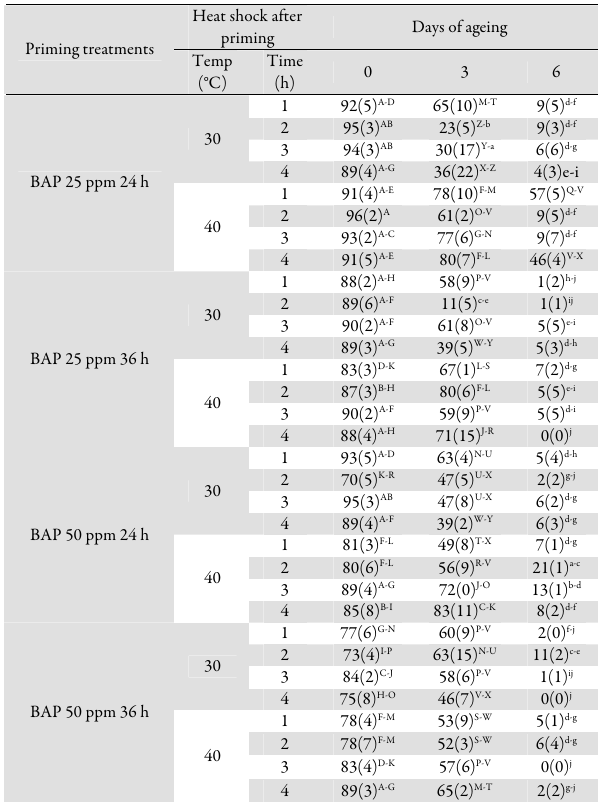
Tab. 1. Normal seedling percentage of Tall wheatgrass seeds at different levels of heat shock followed by priming treatments; the LSD 0.05 for normal seedling (%) is